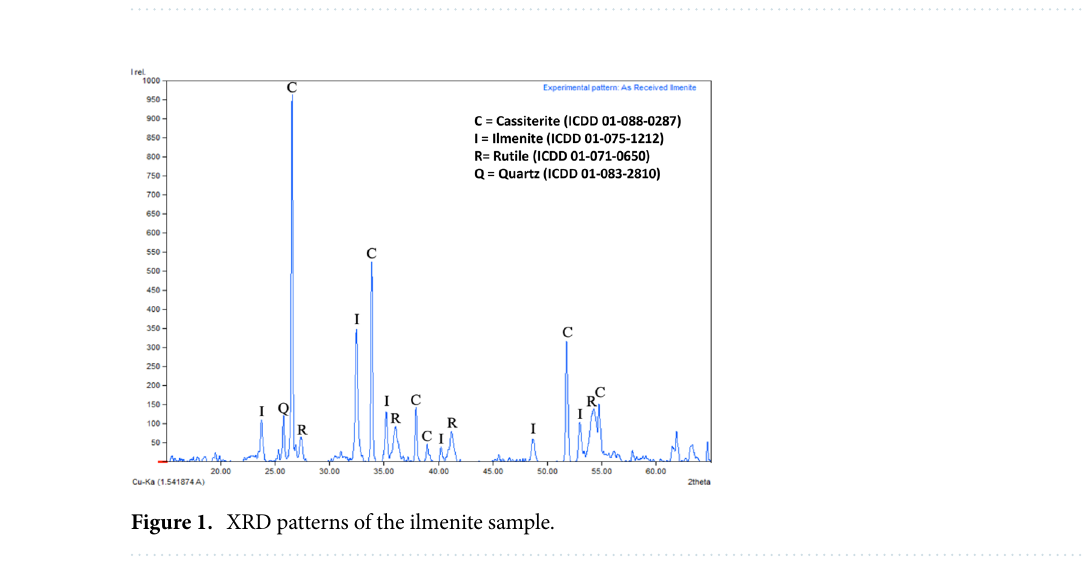
Table 1. Chemical composition of the ilmenite sample.